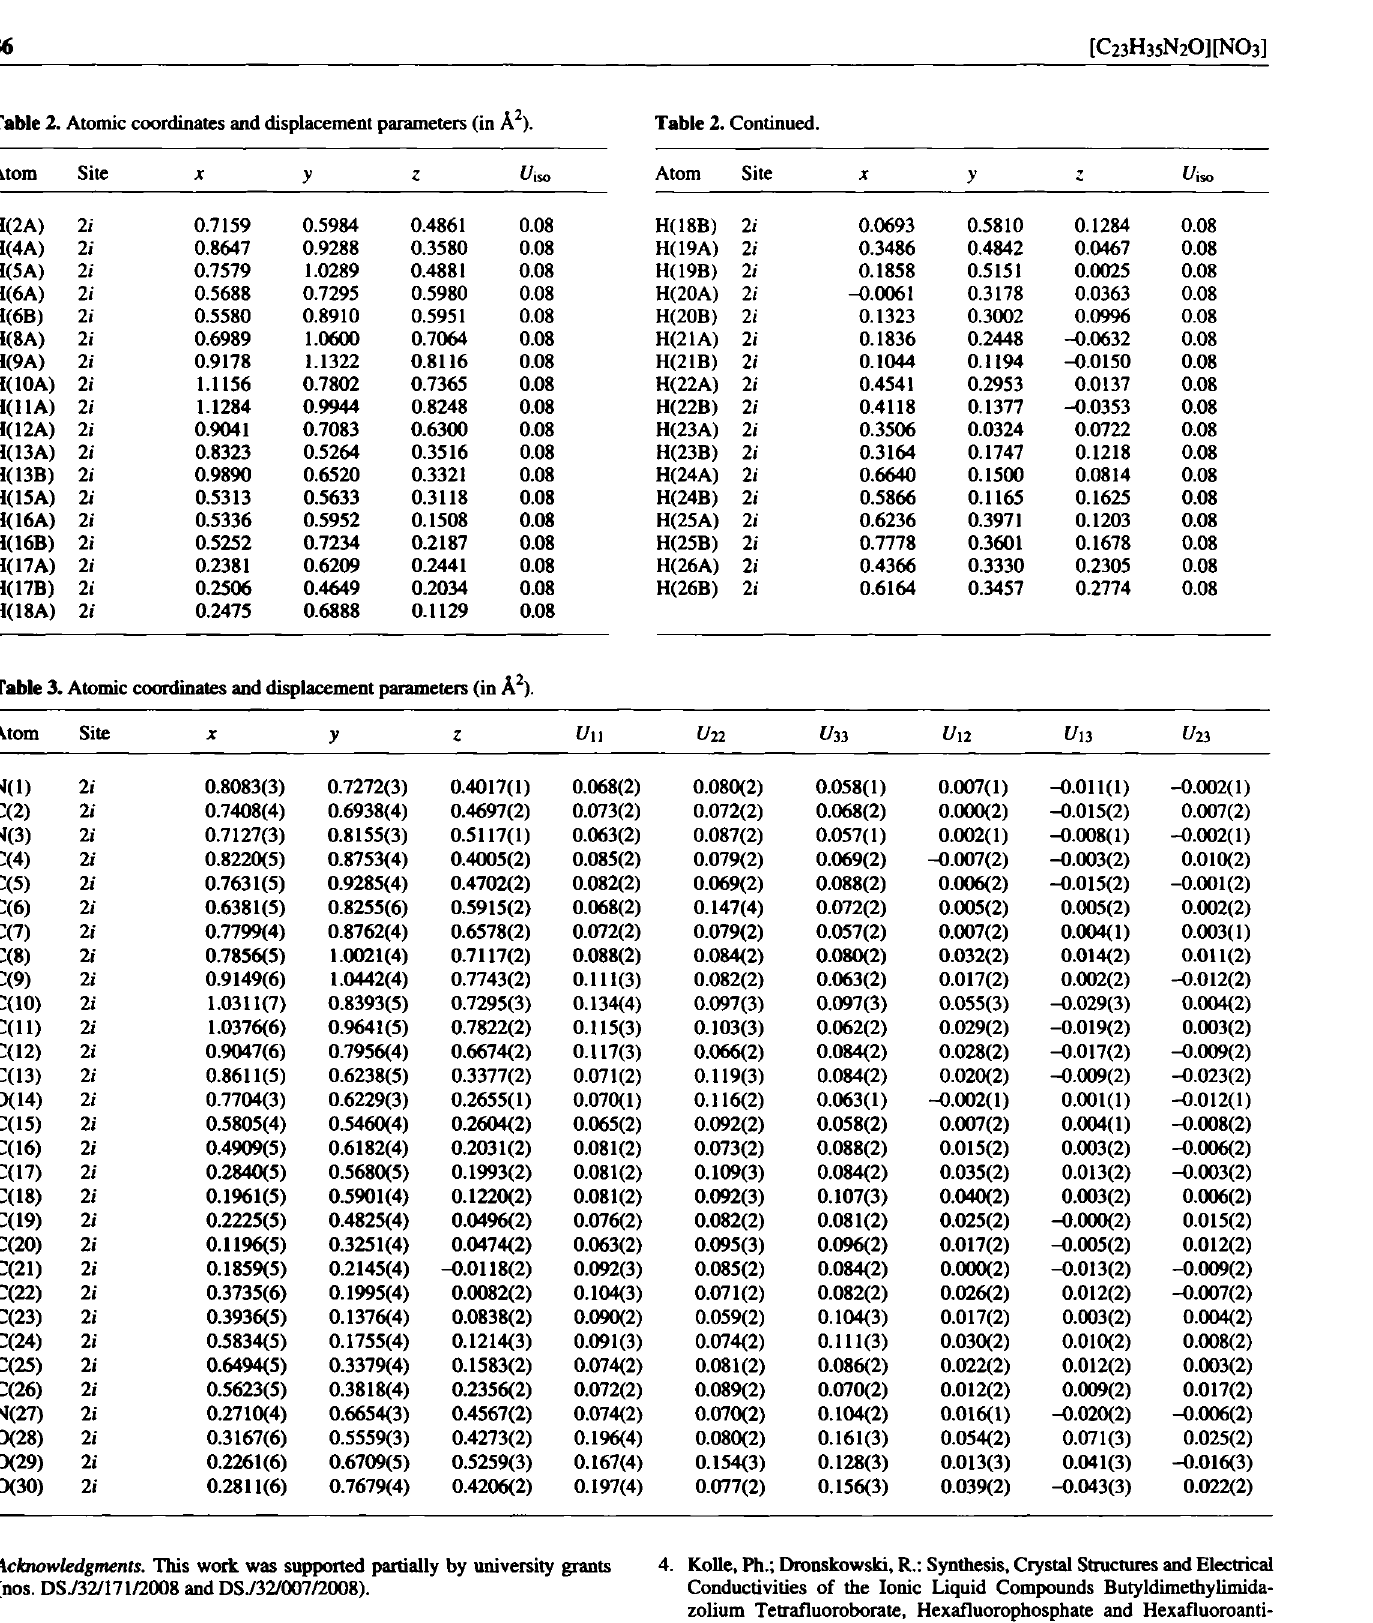
Table 2. Atomic coordinates and displacement parameters (in Â 2 ).